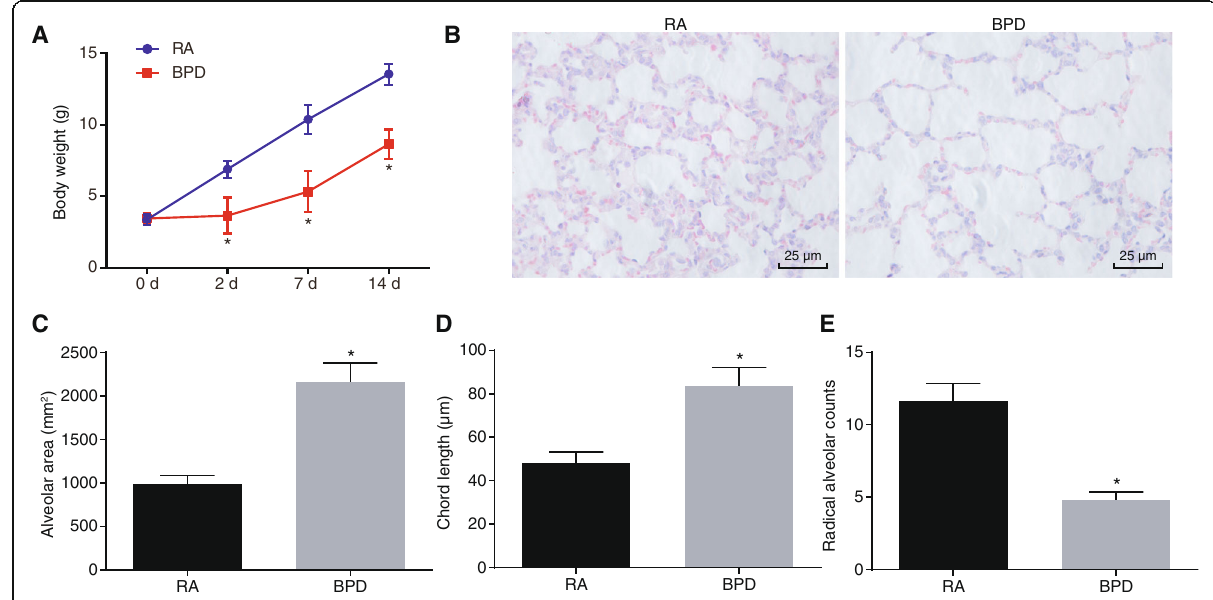
Fig. 1 Hyperoxia-induced BPD mouse models are successfully established. A, Body weight of neonatal mice under exposure of RA or hyperoxia. B, HE staining of lung tissues of neonatal mice under exposure of RA or hyperoxia (× 400). C, Alveolar cavity area in lung tissues in neonatal mice under exposure of RA or hyperoxia. D, Alveolar chord length in lung tissues in neonatal mice under exposure of RA or hyperoxia. E, RAC in lung tissues of neonatal mice under exposure of RA or hyperoxia. N = 15. * p < 0.05 vs. the neonatal mice under RA exposure (the RA group). Measurement data were expressed as mean ± standard deviation. Data comparison between two groups was examined by unpaired t -test. Comparison of data at different time points was examined by repeated-measures analysis of variance. BPD, bronchopulmonary dysplasia; RA, room air; HE, hematoxylin-eosin; RAC, radial alveolar